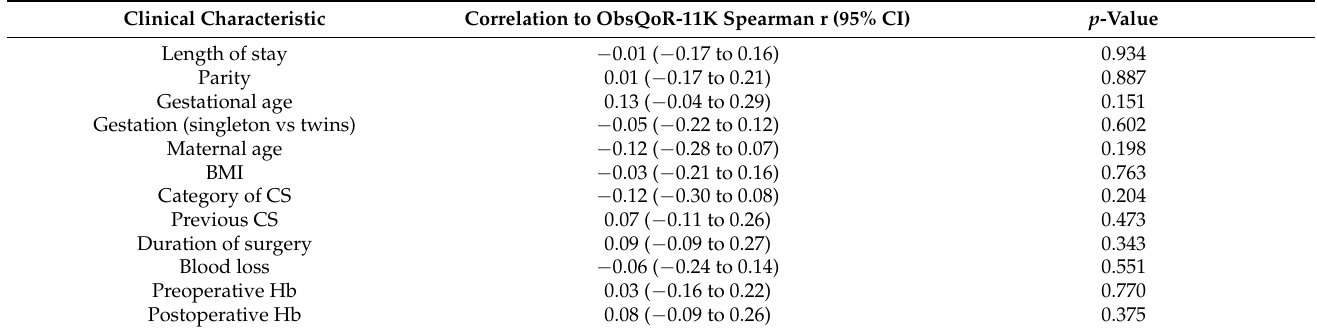
Table 3. Summary of correlations of clinical characteristics to ObsQoR-11K score.